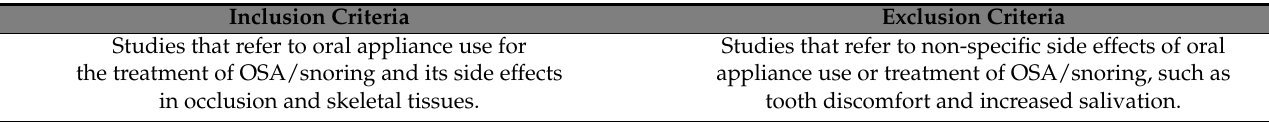
Table 2. Inclusion and exclusion